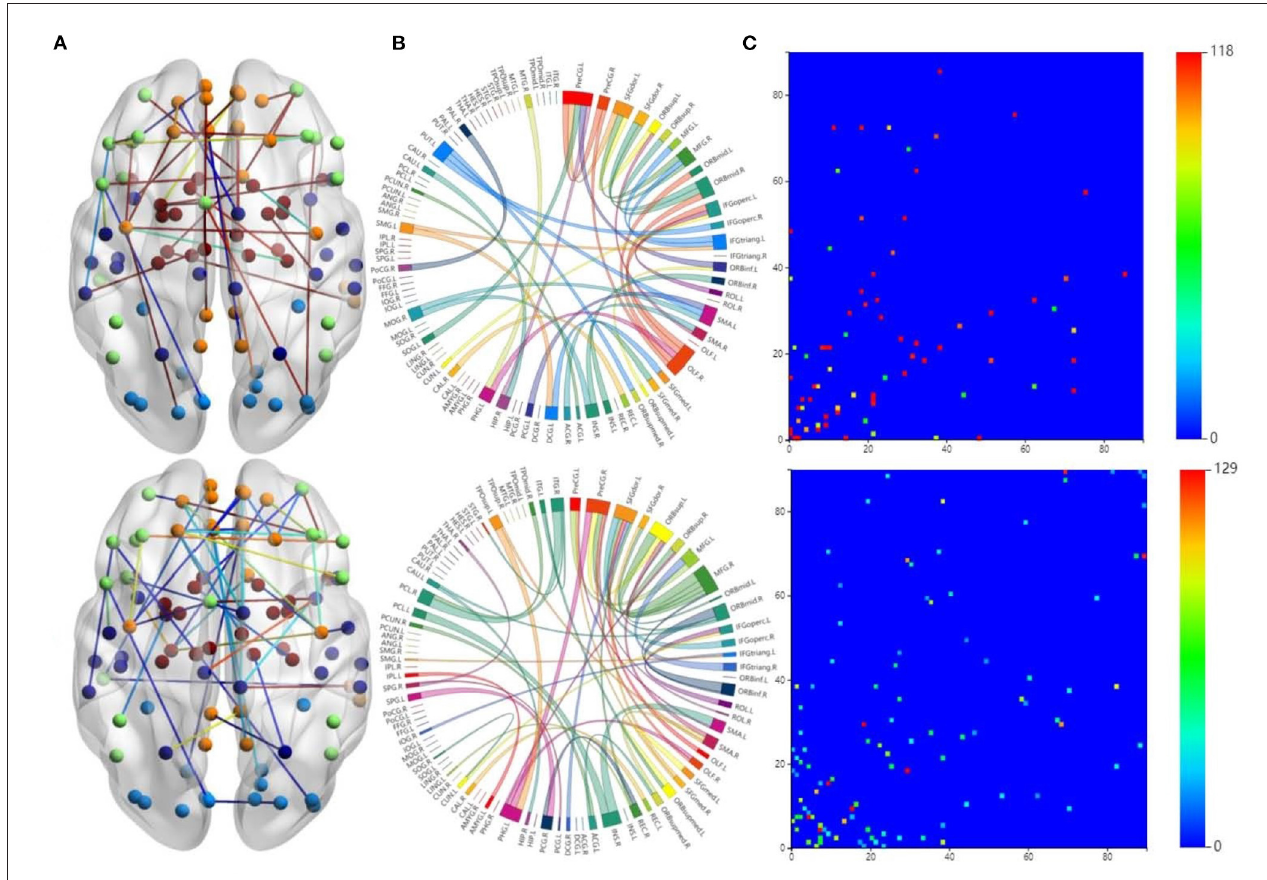
FIGURE 3 | Visualizations of the connectivity of HC and neuropsychiatric disorders (NDs) in different manners on the CNP dataset. The first row and second row show the HC group and ND group, respectively. (A) Shows the connectivity in glass brain plots. (B) Shows the connectivity in circle plots. (C) Shows the connectivity in symmetric